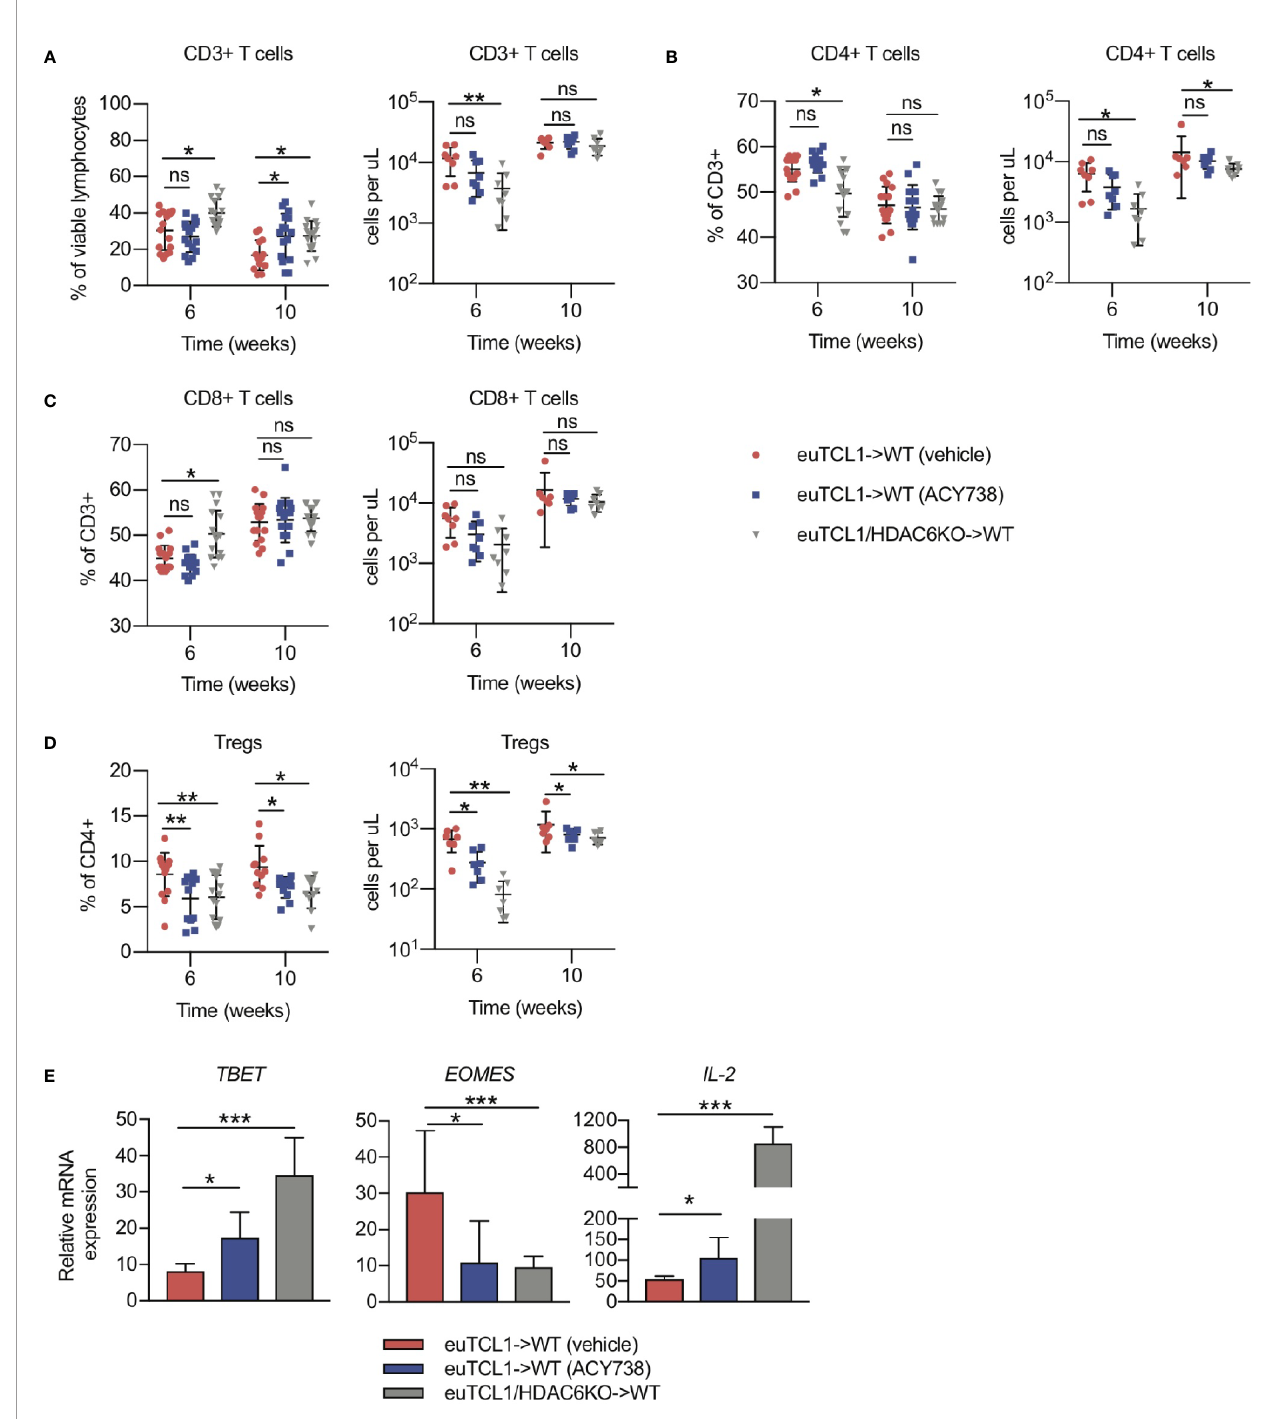
FIGURE 2 | Effects of HDAC6 de fi ciency on CLL T-cell dysfunction. Flow cytometry to detect immune populations in fresh PBMCs of mice in Figure 1 . (A – C) Percentages and counts of CD3 + , CD4 + and CD8 + T cells. (D) Percentages and counts of Tregs out of CD4 + gate. Tregs were gated as CD4 + CD25 HI CD127 LO . Percentages are compiled from 2 independent experiments, n = 12 – 14 mice per group. Counts are shown from 1 representative experiment, n = 8 mice per group. (E) Relative mRNA expression (ddCT) of T-bet , Eomes , and IL-2 in isolated splenic T cells of mice from indicated groups, n = 3 mice per group. Normalized to 18s control gene. Graphs display mean + SD. * p < 0.05, ** p < 0.005, *** p < 0.0005. ns, not signi fi